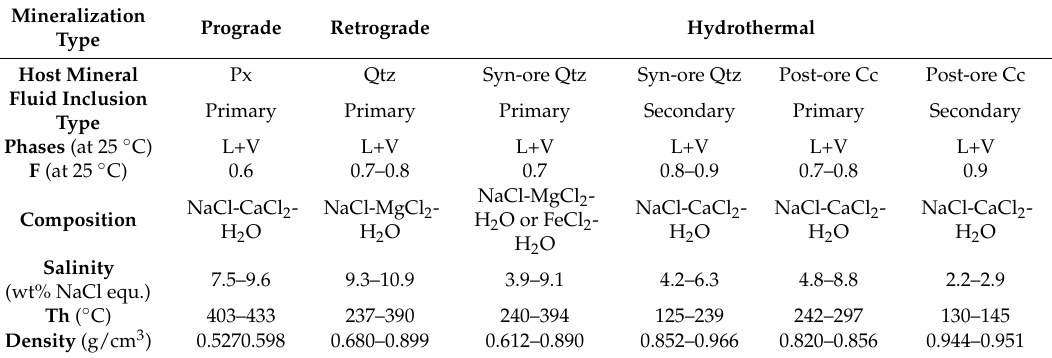
Table 3. Summary of the fluid inclusion data obtained from the Sasa Pb-Zn-Ag skarn